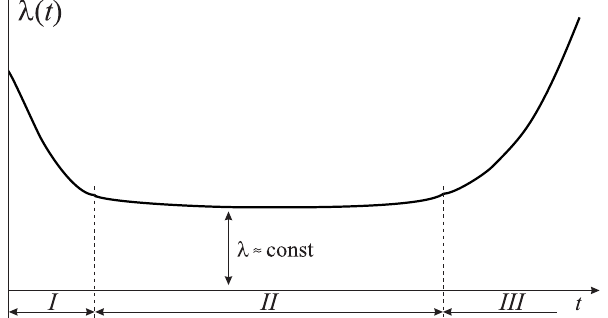
Figure 1. Failure rate graph λ ( t )